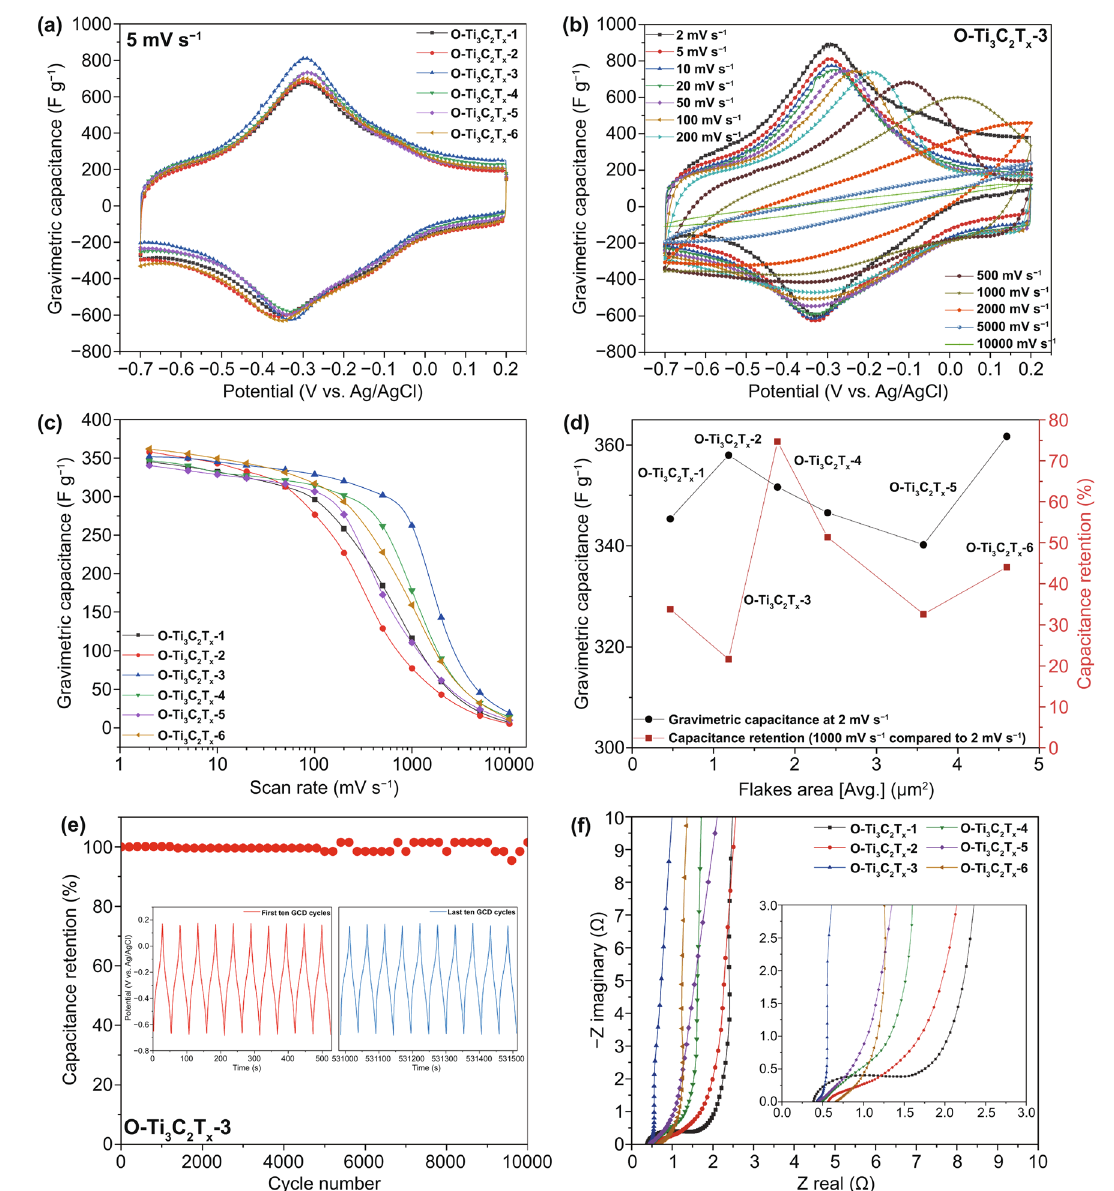
Fig. 5 Electrochemical performance of O-Ti 3 C 2 T x film electrodes. a Cyclic voltammogram profiles collected in 3 M H 2 SO 4 at 5 mV/s scan rate of O-Ti 3 C 2 T x film electrodes from products of different cycles (denote as O-Ti 3 C 2 T x -1 to O-Ti 3 C 2 T x -6). b CV profiles of O-Ti 3 C 2 T x -3 at scan rates from 2 mV s −1 to 10 V s −1 . c Gravimetric capacitance of O-Ti 3 C 2 T x film electrodes at different scan rates d Gravimetric capacitance at scan rate of 2 mV s −1 and rate performance (scan rate at 1000 mV s −1 compared to at 2 mV s −1 ) of O-Ti 3 C 2 T x film electrodes versus different flakes areas. e Capacitance stability of O-Ti 3 C 2 T x -3 performed by GCD cycling at 10 A g −1 . The insets depict GCD cycling profiles collected at first ten cycles (red) and last ten cycles (blue), respectively. f Electrochemical impedance spectroscopy (EIS) for O-Ti 3 C 2 T x film electrodes. The inset shows a magnification of the high-frequency